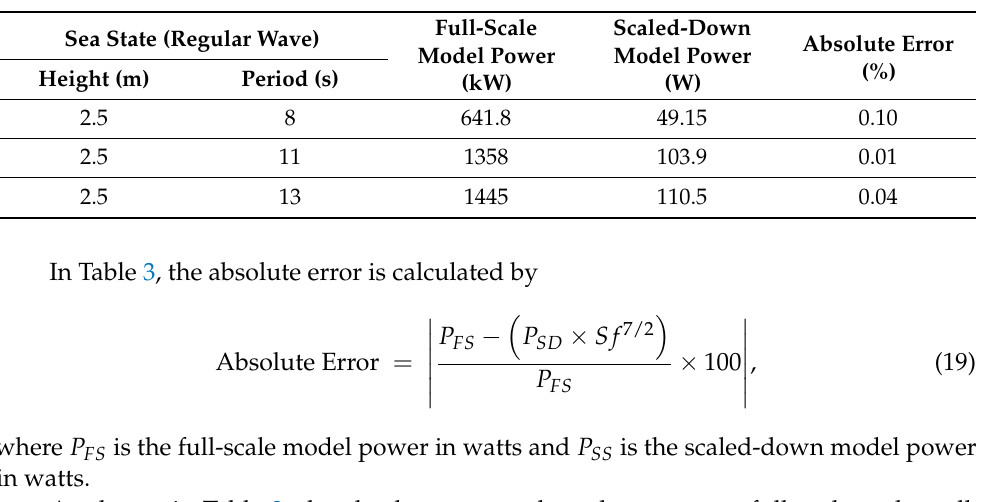
Table 3. Numerical model